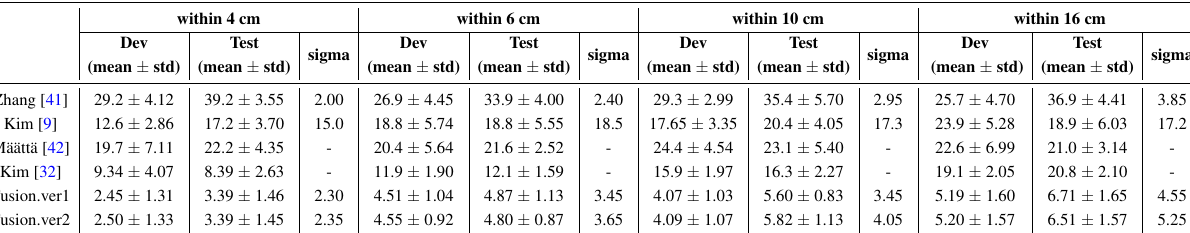
Table 5. Performance comparison (HTER